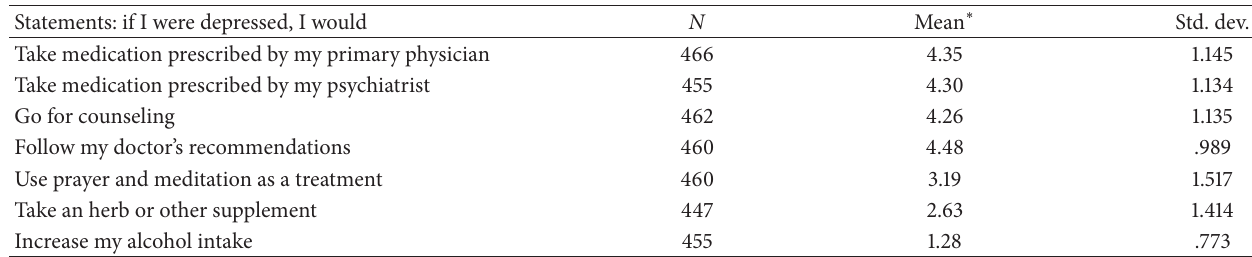
Table 3: Treatment